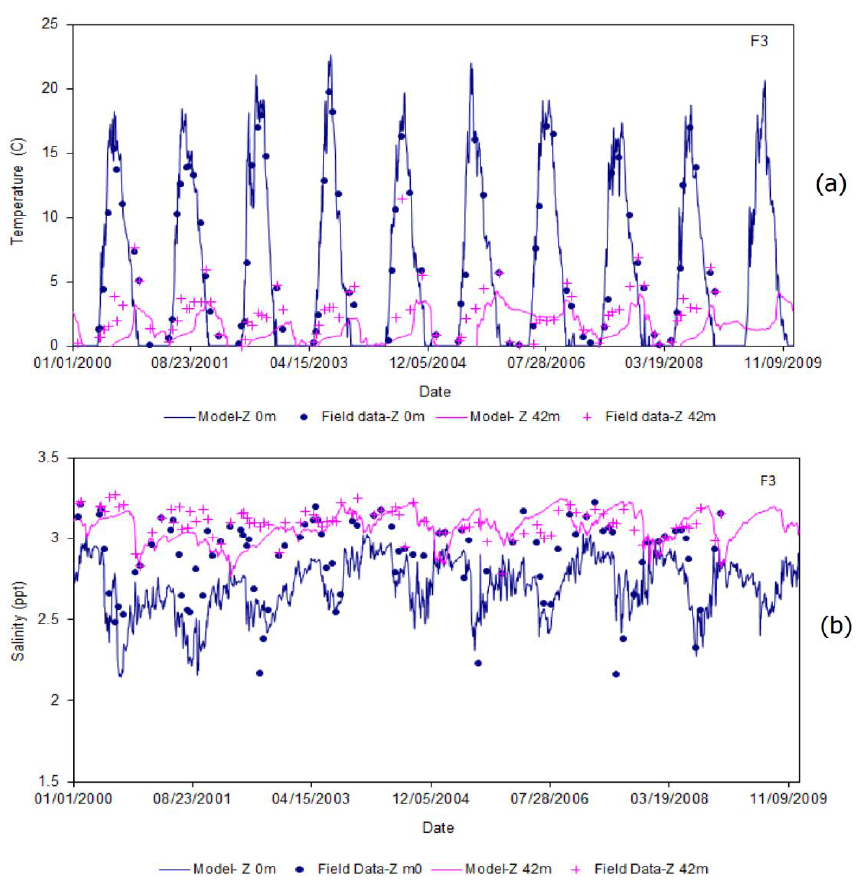
Figure 7. ( a ) Comparison of model predicted and measurements of temperature in the Baltic Sea at the Station F3 surface and 42 m depth for the time period 2000–2009; ( b ) Comparison of model predicted and measurements of salinity in the Baltic Sea at the Station F3 surface and 42 m depth for the time period 2000–2009.